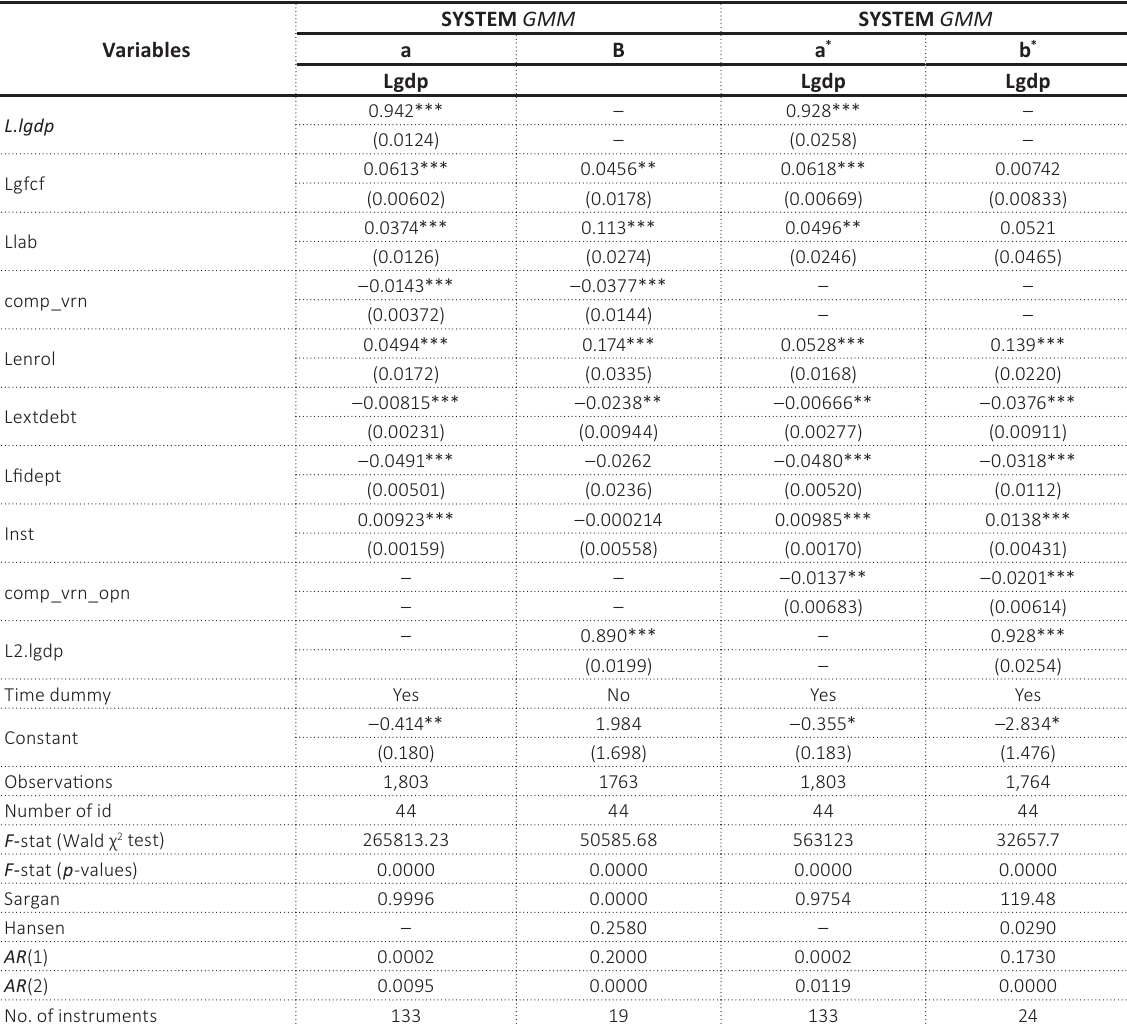
Table 3. Commodity price interacted with trade openness